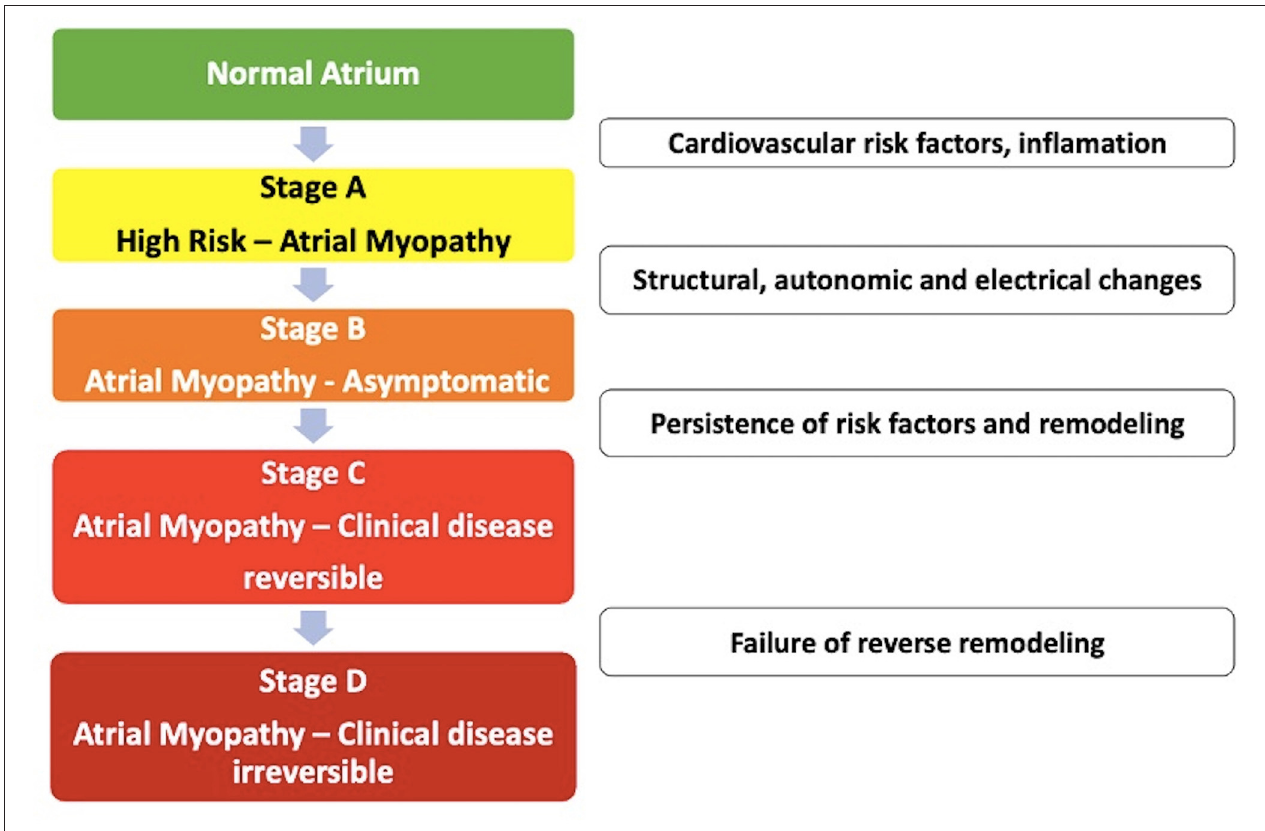
FIGURE 1 | Evolutionary stages of atrial